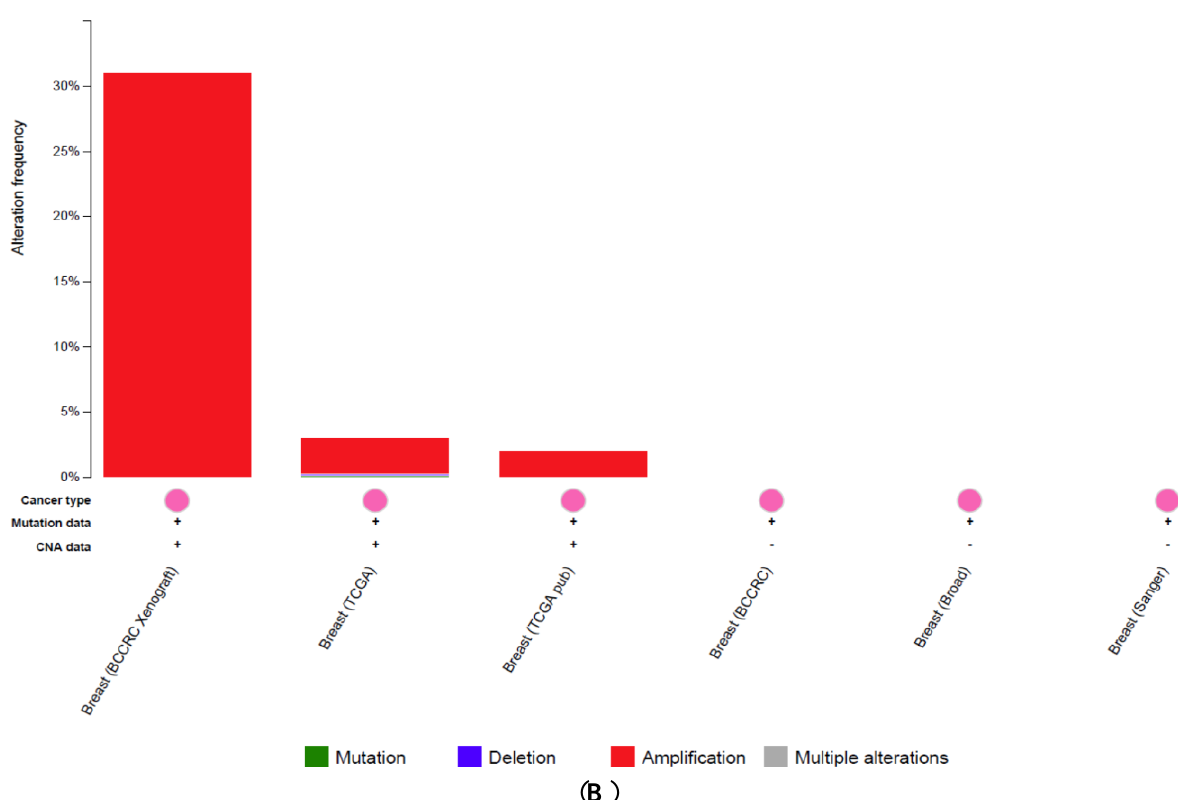
Figure 1. Alterations of claudin (CLDN) family members in breast cancer database. ( A ) Alteration pattern (amplification, upregulation, downregulation, mutation and homozygous deletion) of CLDN family members including CLDN1 to CLDN25 except CLDN13 and 21; ( B ) CLDN1 alterations in invasive breast carcinoma collected from six different datasets.